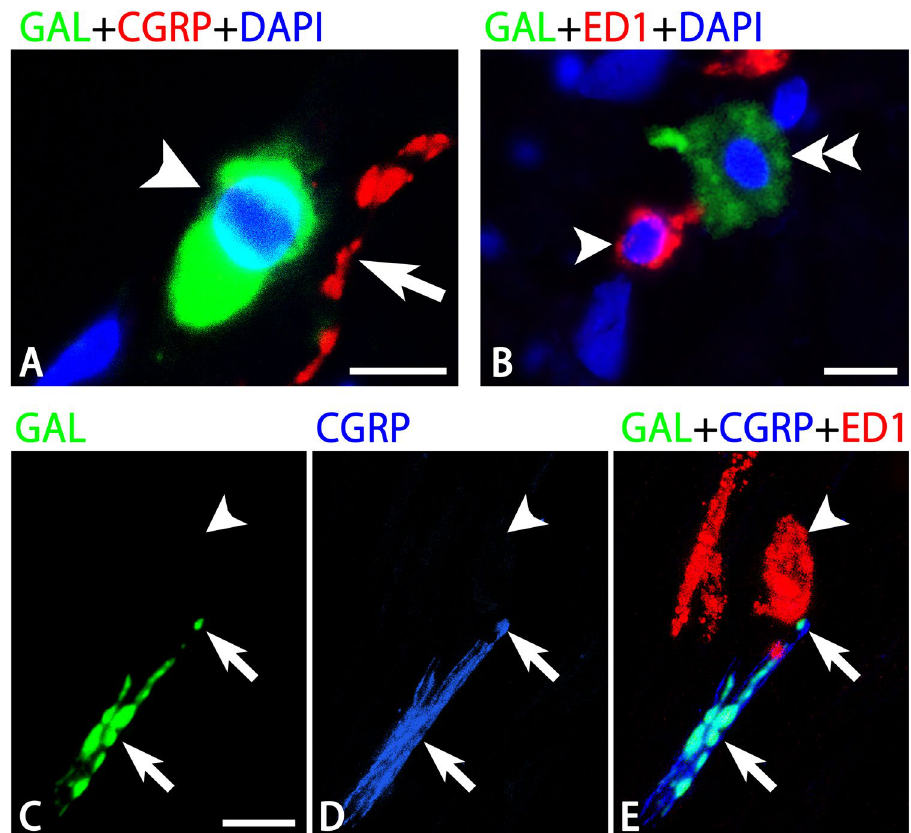
Figure 6. Photomicrographs for GAL ( A , B , C , E ), CGRP ( A , D , E ), ED1 ( B , E ) and DAPI ( A , B ) in the dura mater by a confocal laser scanning microscope. Panels ( C – E ) are from the same field of view. CGRP-ir varicose fibers (an arrows in A ) in the vicinity of a GAL-ir cell (an arrowhead in A ) often lack GAL-immunoreactivity. A GAL-ir cell (a double arrowhead in B ) is also detected in the vicinity of ED1-ir cells without GAL- immunoreactivity (an arrowheads in B ). A nerve fiber that co-expresses GAL- and CGRP-immunoreactivity (arrows in C – E ) are observed in the vicinity of an ED1-ir cell (arrowheads in C – E ). Bars = 10 µm ( A – C ). Panels ( C – E ) are at the same